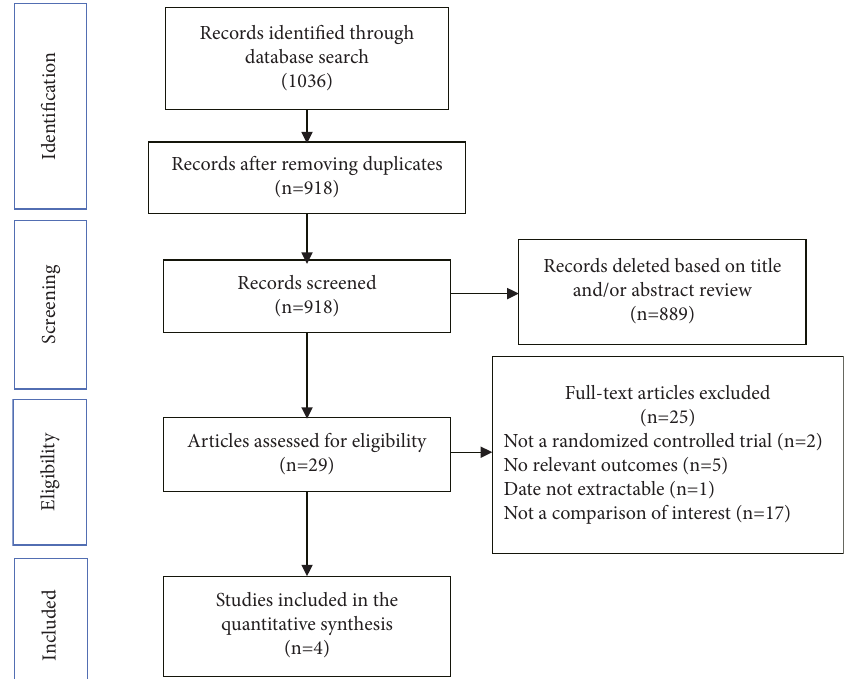
Figure 1: Te fow diagram depicting the selection of studies included in the